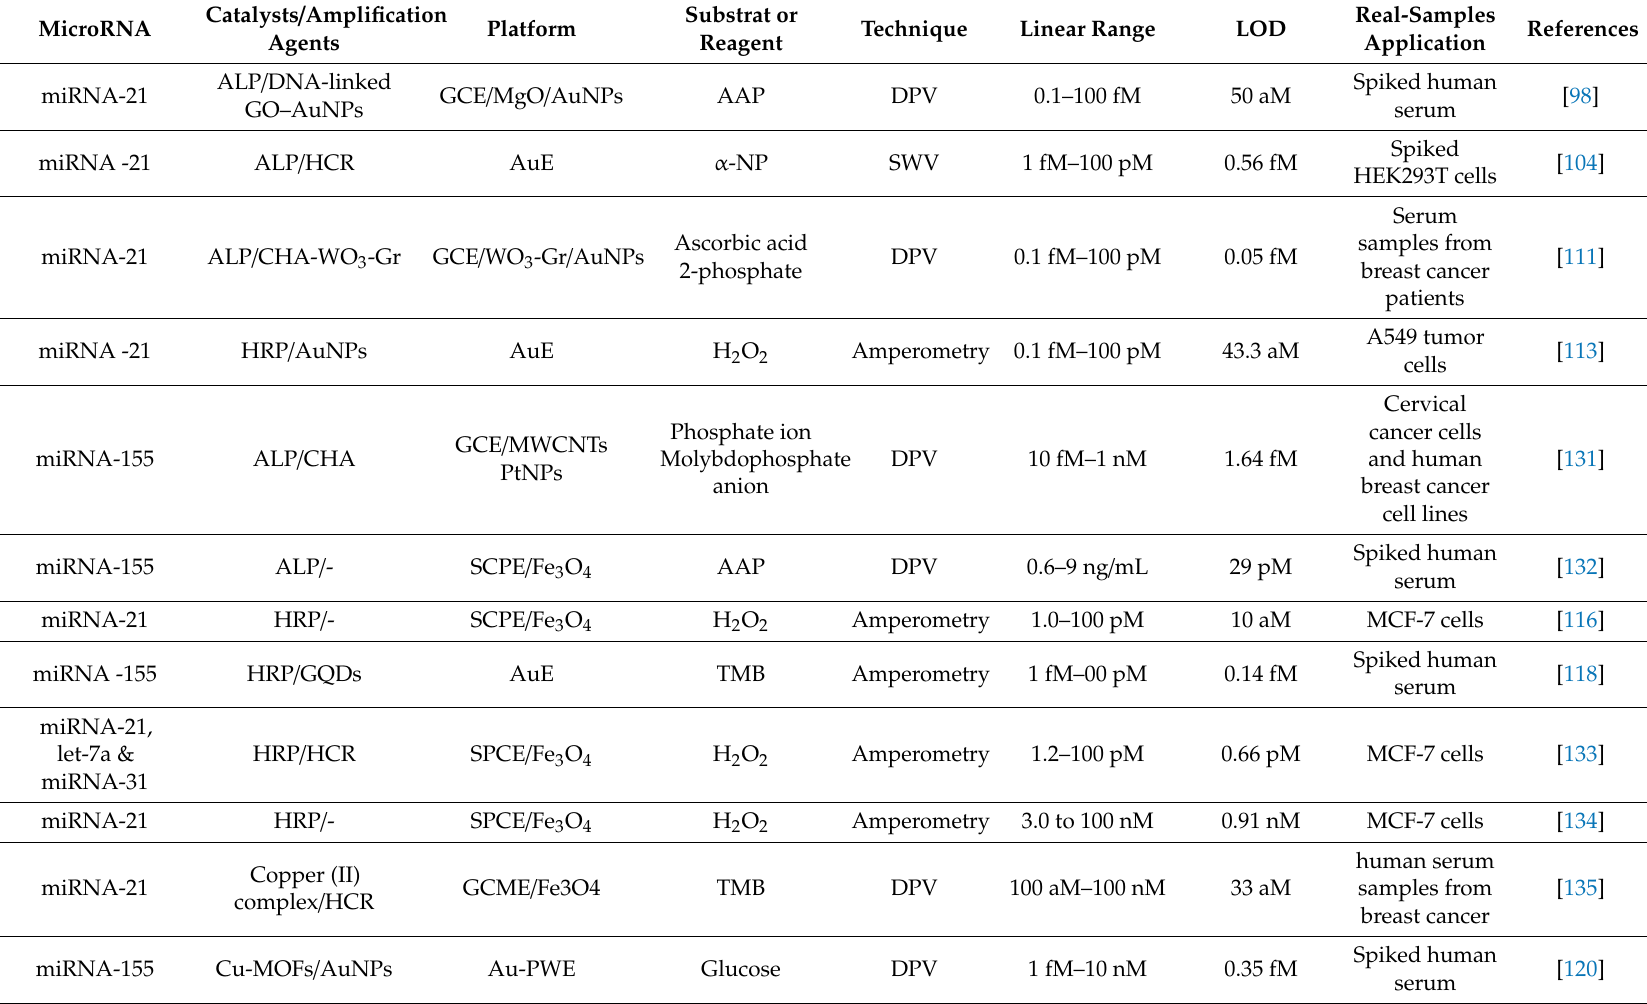
Table 3. Current sensitive electrochemical biosensors using